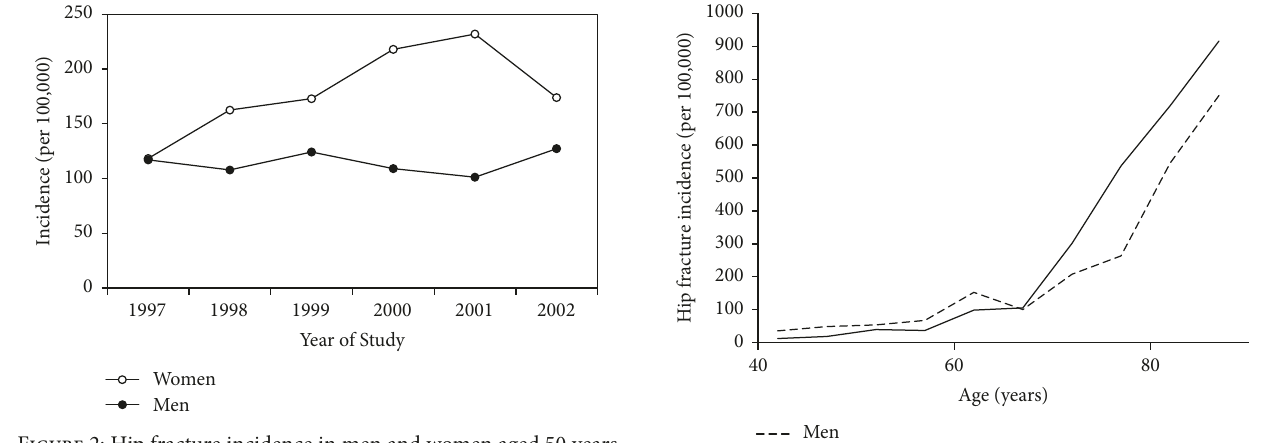
Figure 2: Hip fracture incidence in men and women aged 50 years and older in Vinnitsa city over the years 1997–2002 inclusively.